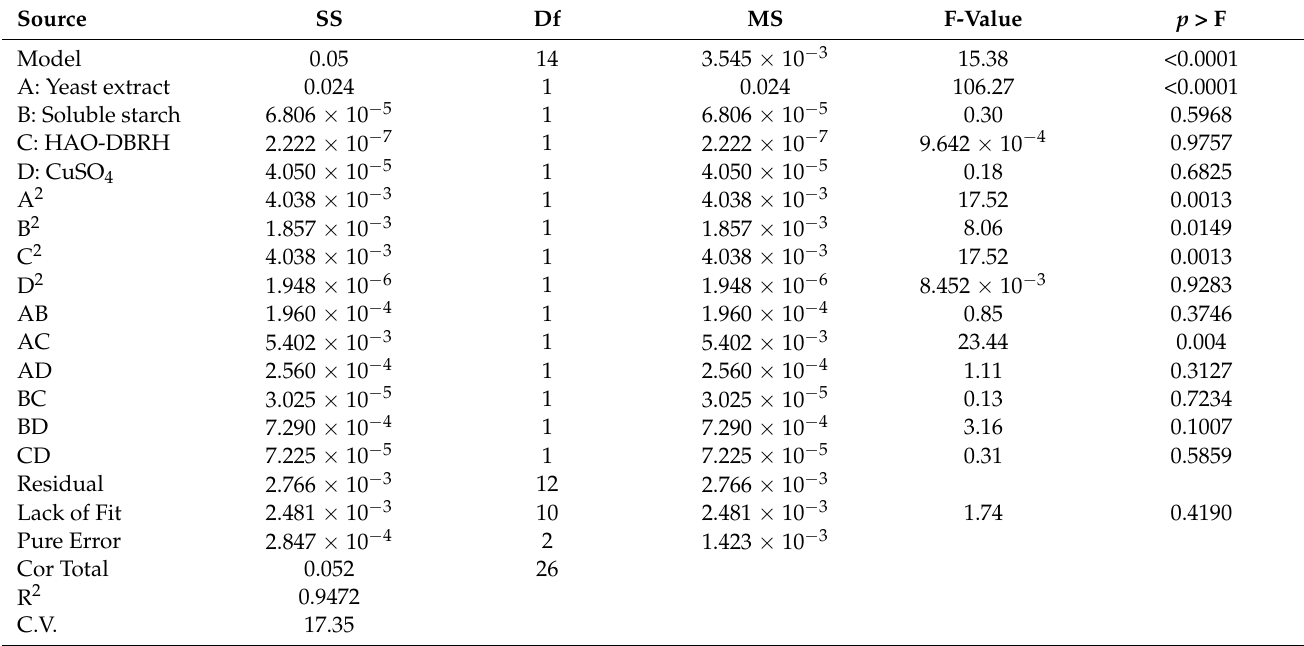
Table 4. ANOVA for response surface quadratic model of response variance.